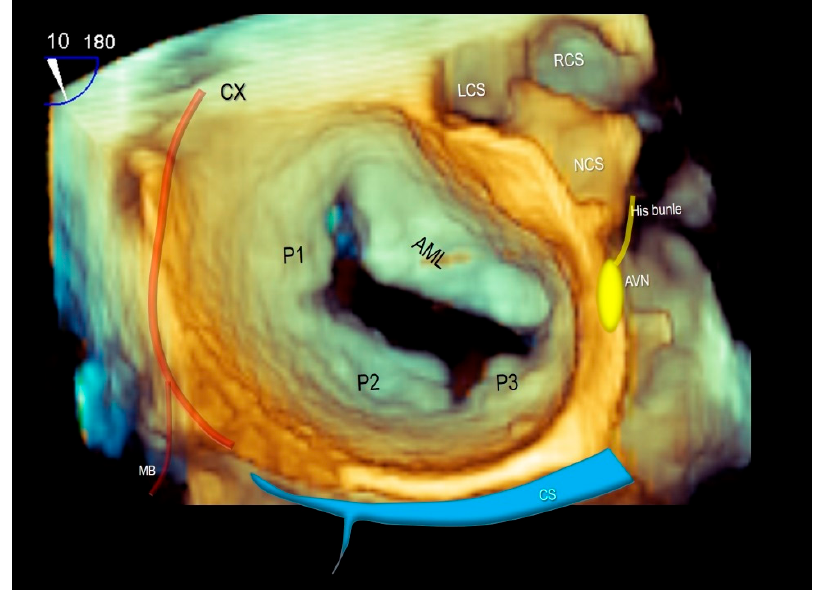
Figure 11. Three-dimensional TEE surgical view of mitral valve showing the anatomical relationships of mitral valve with the circumflex coronary artery (CX), the coronary sinus (CS) and the atrio-ventricular node (AVN). AML = anterior mitral leaflet, P1 – P2 – P3 = scallops of posterior mitral leaflet, LCS = left coronary sinus, RCS = right coronary sinus, NCS = non-coronary sinus, MB = marginal branch of CX.